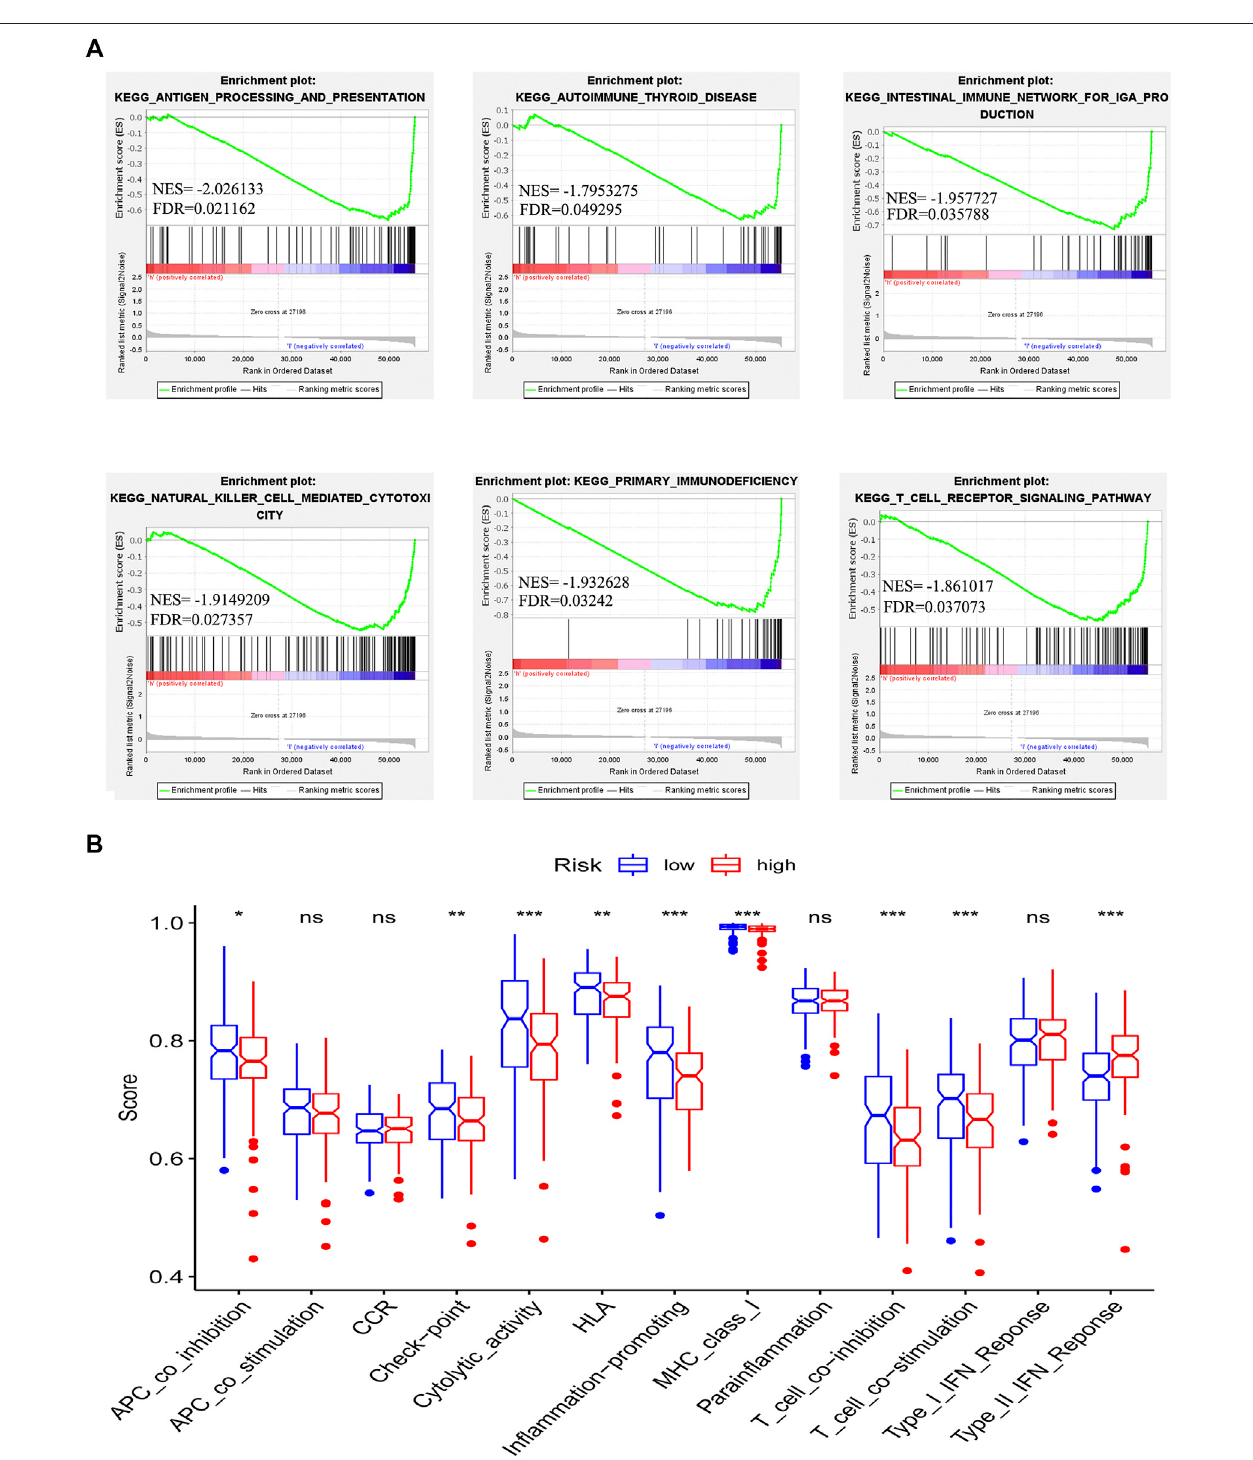
FIGURE 5 | Correlation between immune microenvironment and risk model. Gene set enrichment analysis based on the chemokine-related lncRNAs risk model (A) .Thedifferenceintheenrichmentofthirteenimmune-relatedpathwaysbetweenthelow-riskgroupandthehigh-riskgroupwasassessed(* p < 0.05,** p < 0.01,*** p < 0.001) (B) .